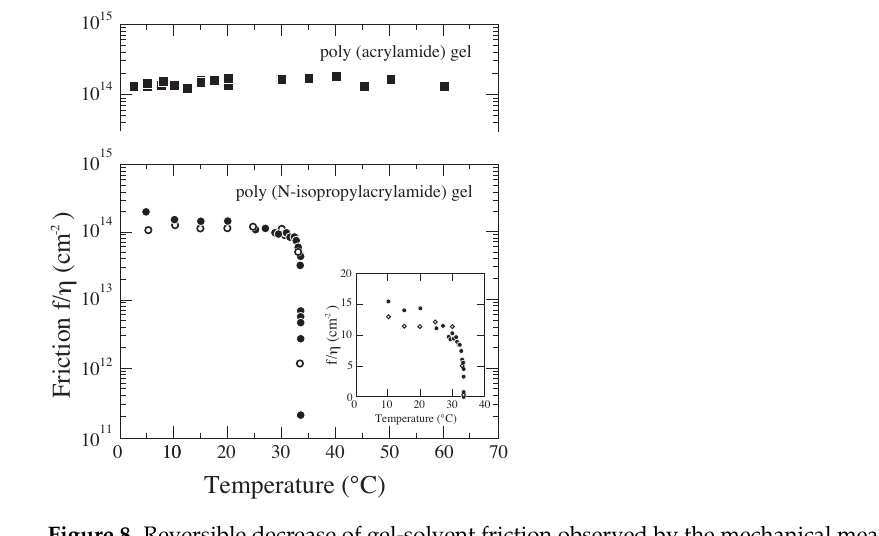
Figure 8. Reversible decrease of gel-solvent friction observed by the mechanical measurements. The inset shows the linear plot of the